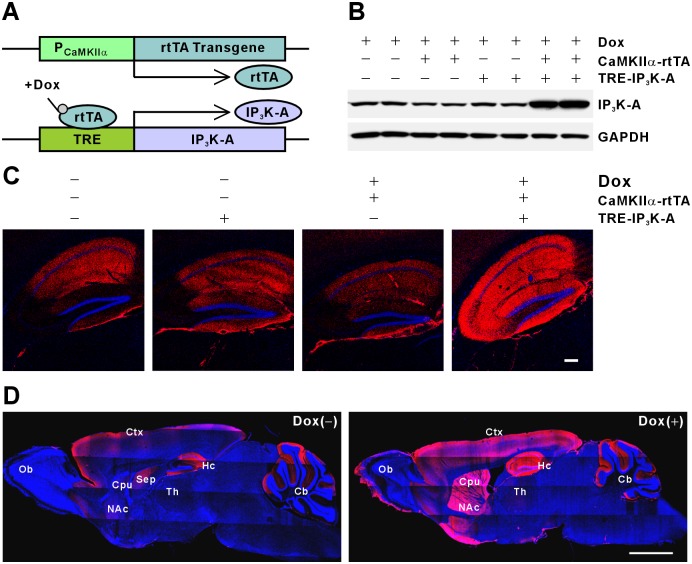
Generation of transgenic mice conditionally overexpressing IP3K-A.(A), Schematic diagram of the Tet-On regulatory system. Reverse tetracycline-controlled transactivator (rtTA) is expressed under the control of the tissue-specific promoter CaMKIIα. The rtTA protein binds and activates transcription of the tetracycline response element (TRE) only in the presence of Dox. (B), IP3K-A transgene expression in a Dox-dependent manner. IP3K-A expression was determined using Western blot of hippocampal lysates. (C and D), Immunohistochemical detection of IP3K-A protein. Coronal hippocampal sections (C) and sagittal whole brain sections (D) of WT and Tg mice fed Dox for 2 weeks immunofluorescence stained for IP3K-A (red) and Hoechst 33342 (blue). The induction pattern of the IP3K-A protein in the hippocampus was analyzed by subtracting the WT signal from the Tg signal. Scale bar, 200 μm (C) and 2 mm (D). Ctx, cortex; Hc, hippocampus; Ob, olfactory bulb; Cpu, caudate putamen; Th, thalamus; Cb, cerebellum.